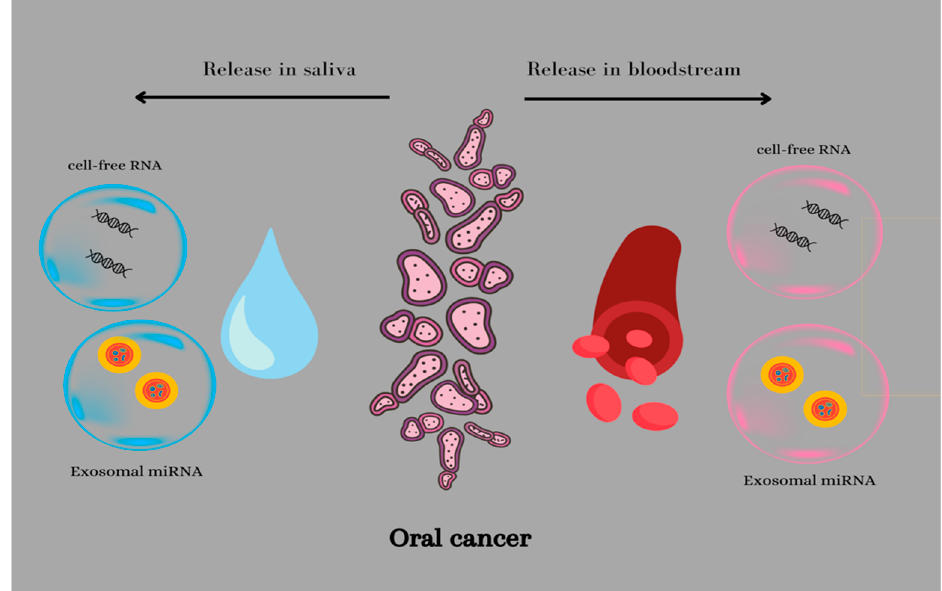
Figure 2. Release miRNA mechanism of oral cancer cells.